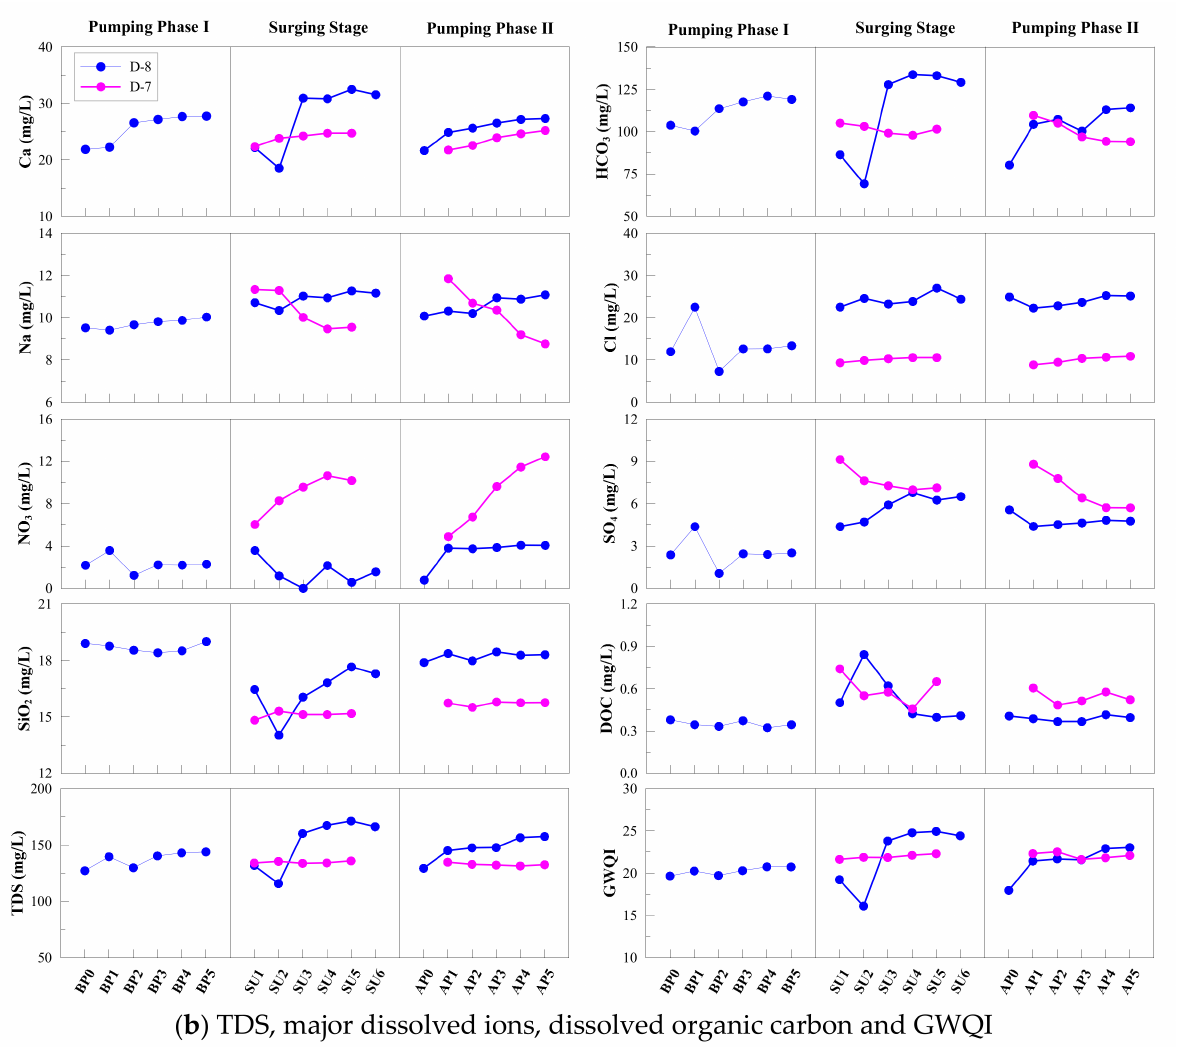
Figure 6. The results of ( a ) changes in field groundwater quality parameters observed during pumping tests and ( b ) variation in the of major ions, total dissolved solids (TDS), dissolved organic carbon, and groundwater quality index (GWQI) in groundwater samples collected during pumping and surging in the D-8 and D-7